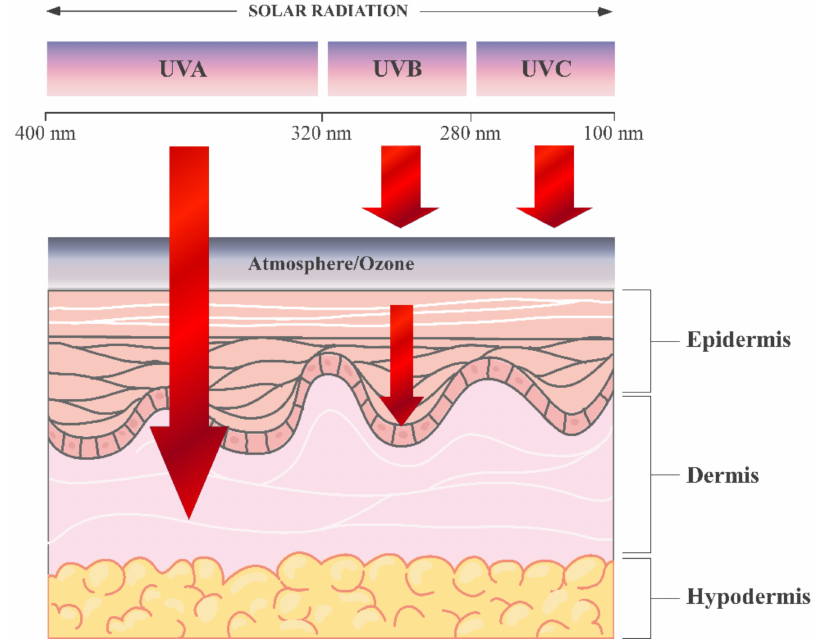
Figure 2. UV penetration into the layers of the skin. The figure was created using Servier Medical Art [19], licensed under the Creative Commons Attribution 3.0 Unported License (www.